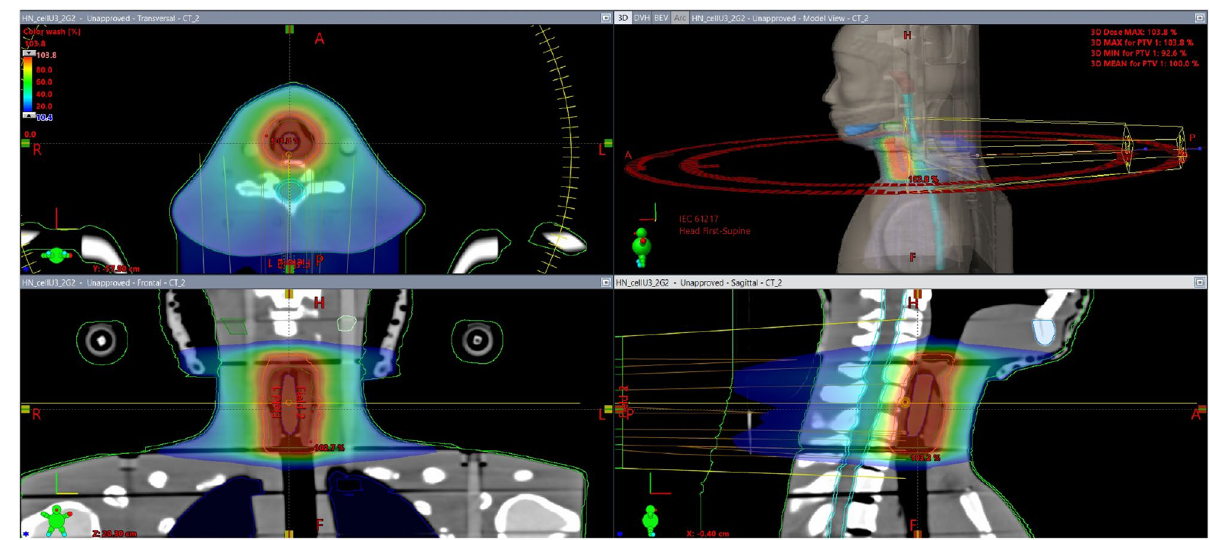
Figure 2. Dose distribution on axial, sagittal, and coronal views and a 3D view of VMAT plans created to irradiate the chondrocyte-like cells in the ART phantom. The air space simulating the esophagus was filled with wax surrounding an Eppendorf tube, as quasi-GTV (blue color), quasi-CTV (green color), and quasi PTV (orange